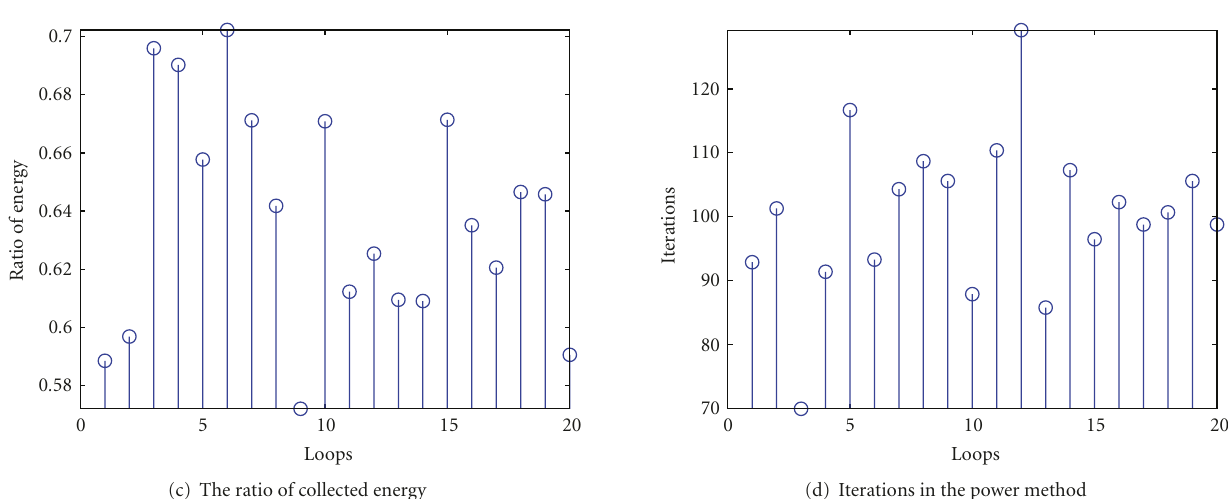
algorithms with lower complexity, such as the power method [19]. For each dominant singular value and vector, the power method has a computational order of M 2 for an M × M Hermitian matrix. To be stated, in the power method, the speed of convergence depends on the ratio between the two largest singular values of the matrix. The larger the ratio is, the faster it